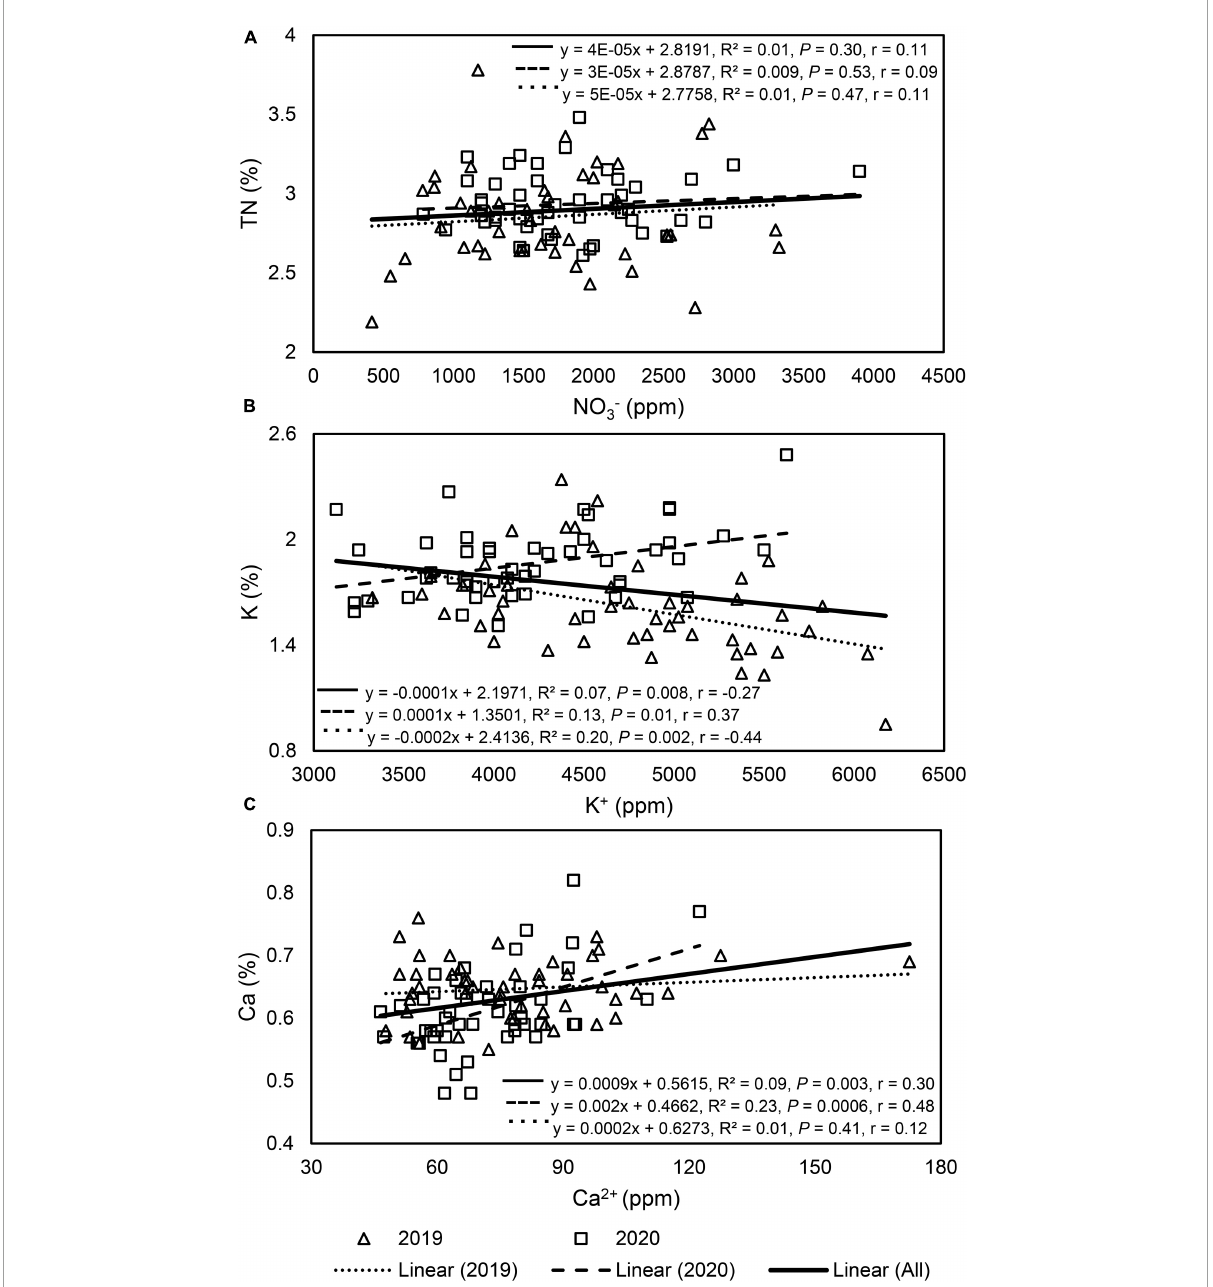
FIGURE2 Linear regression graphs, equations, coefficients of determination (R 2 ), P -values, and Pearson correlation coefficients (r) of each paired variable in “Meeker” floricane raspberry: (A) petiole sap nitrate (NO 3 – ) and leaf tissue total nitrogen (TN), (B) petiole sap potassium (K + ) and leaf tissue K, and (C) petiole sap calcium (Ca 2 + ) and leaf tissue Ca. In each graph, the dashed and dotted line was each analyzed with 48 paired samples by year, while the solid line was analyzed with all ( n = 96) paired samples throughout 2